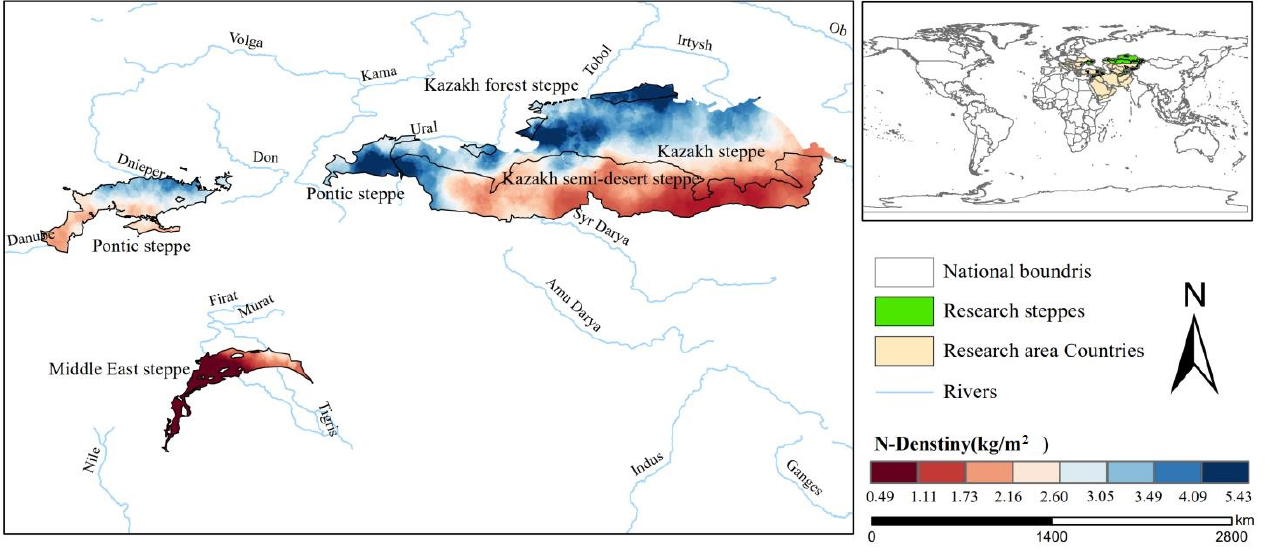
Figure 2. Pattern of spatial distribution of nitrogen concentration in five typical Central Asian steppe soils (0–100 cm). The map is based on the standard map No.GS(2021)5453 downloaded from the